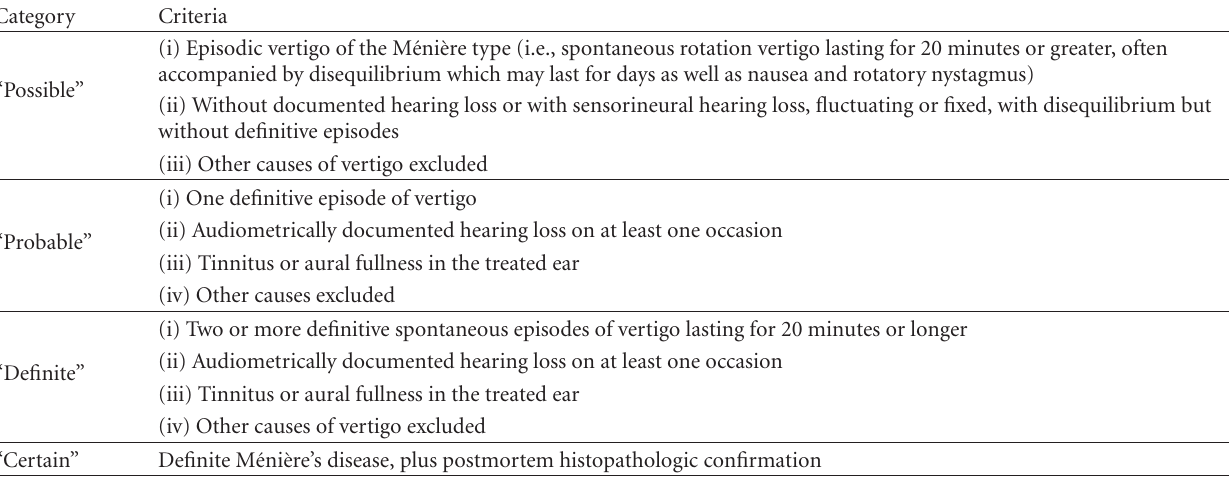
Table 1: The 1995 AAO-HNS criteria for the diagnosis of M´eni`ere’s disease (adapted from [4, page 182]).